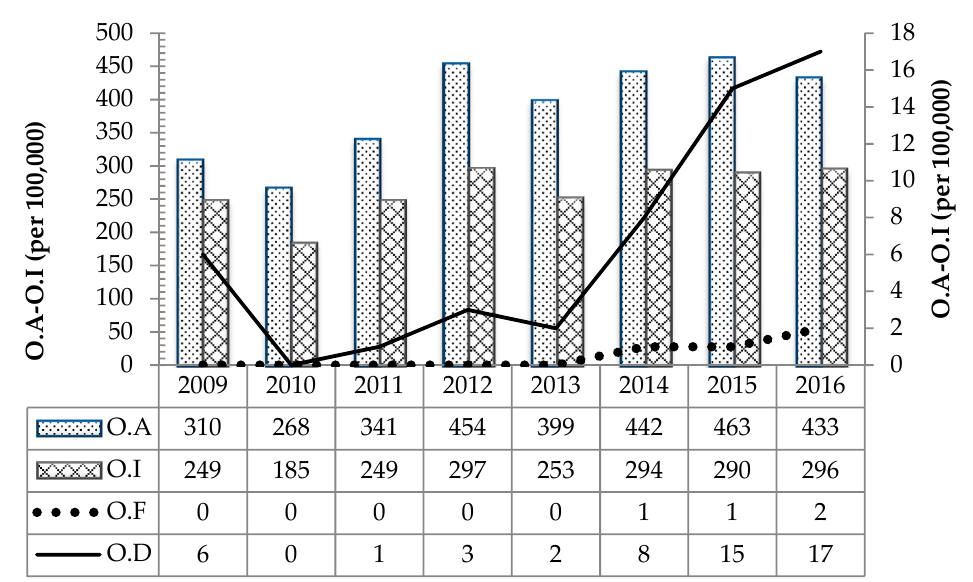
Figure 6. The OSH statistics in the industrial sectors between the years 2009 and 2016. Where: O.I = Occupational Injuries, O.A: Occupational Accidents, Occupational Diseases, and O.F: Occupational Fatalities.